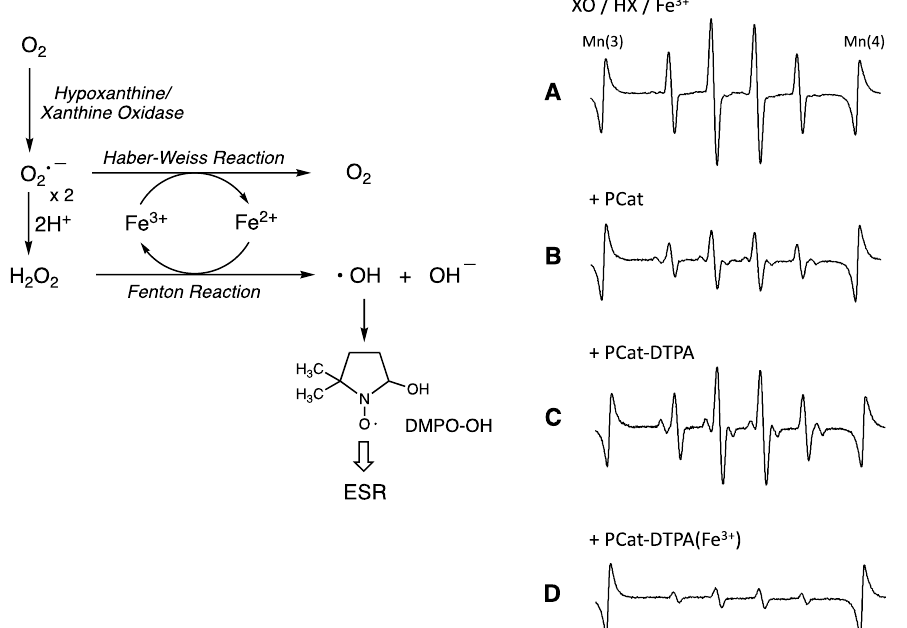
Figure 4. Effects of PCat analogs on hydroxy radical adduct formation of DMPO in the Fe-XO/HX system. ESR spectra of spin adducts were observed during the reaction of hypoxanthine (0.2 mM), xanthine oxidase (0.05 U/mL), and FeCl 3 (0.01 mM) in the absence ( A ) or presence of PCat analogs (0.1 mM; ( B ): PCat, ( C ): PCat-DTPA, ( D ): PCat-DTPA(Fe 3+ )).